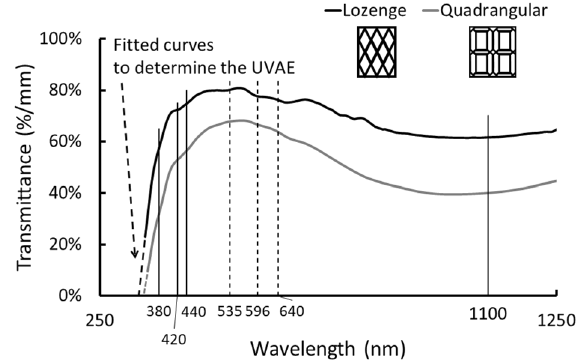
Figure 1. Transmission spectra normalized to a 1-mm glass thickness show the presence of iron and cobalt impurities. Solid (Fe 2+ and Fe 3+ ) and dashed (Co 2+ ) lines mark the absorption band positions. The differences in UVAE values are visualized.